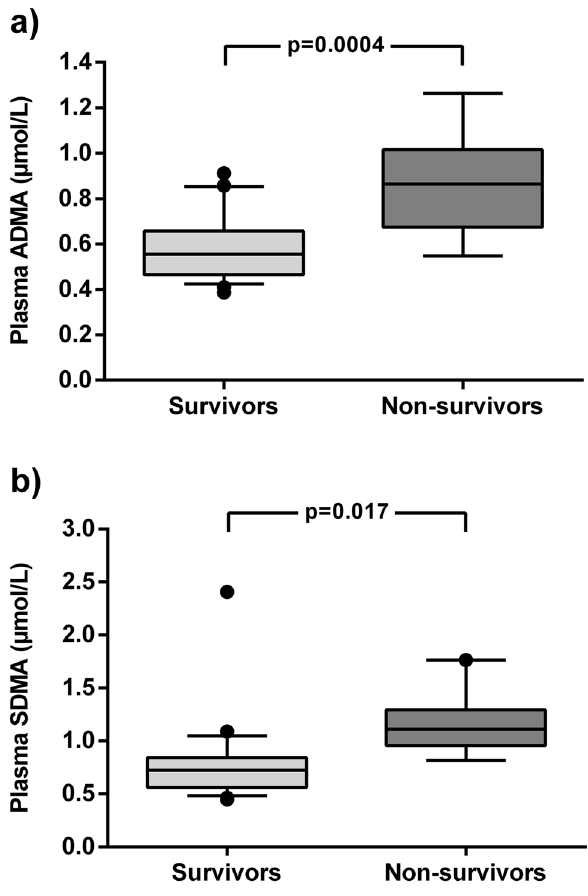
Figure 1. Box plots of the serum concentrations of ADMA ( a ) and SDMA ( b ) in the initial blood sample of hospitalized COVID-19 patients (N = 31). Boxes show median ± interquartile range, with whiskers representing 10th to 90th percentile; outliers are plotted